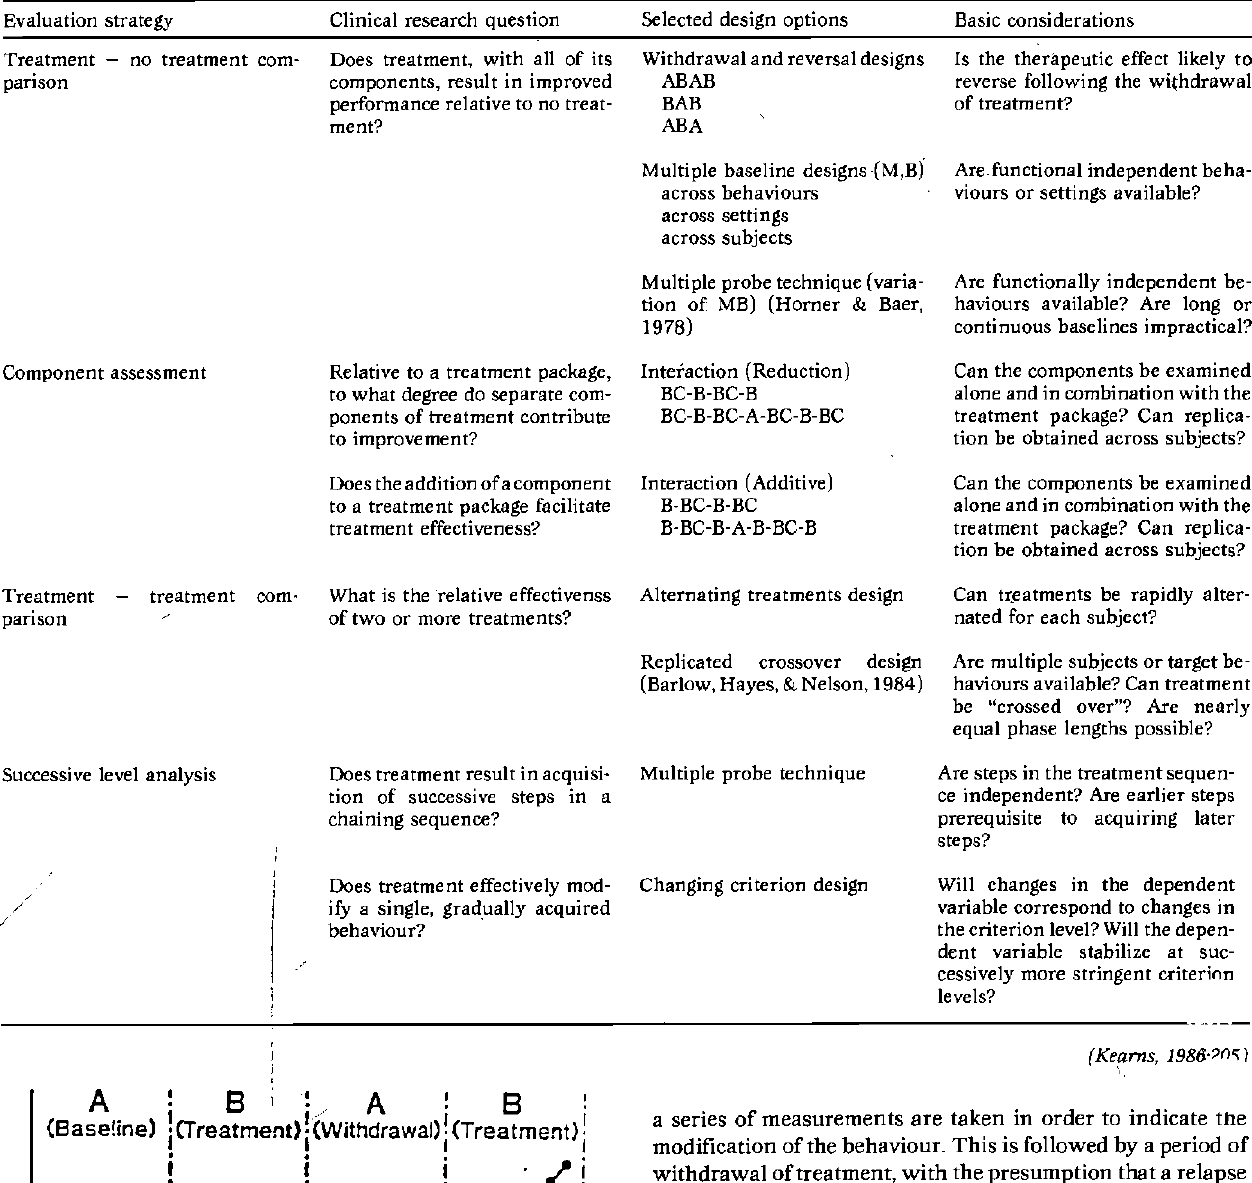
Table 1. Evaluation strategies, research questions, design options, and considerations for single-subject experimental designs.